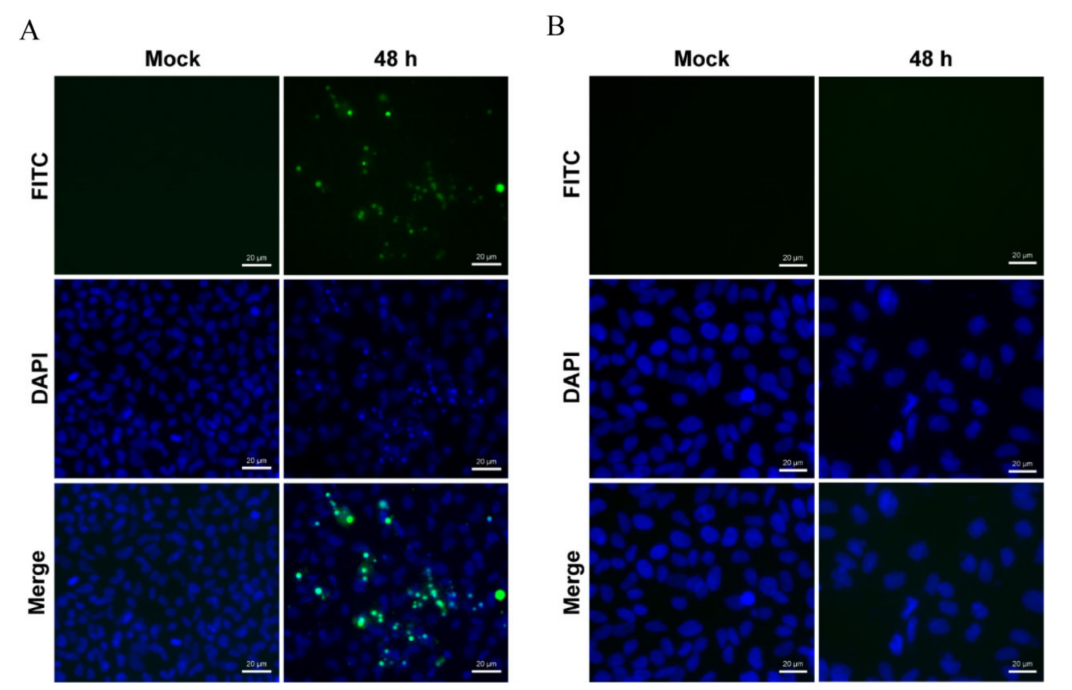
Figure 5. TUNEL staining of LMBV-infected cells. LMBV infected FHM ( A ) and MsF ( B ) cells were stained with TUNEL and DAPI, and the fluorescence was observed under fluorescence microscopy.